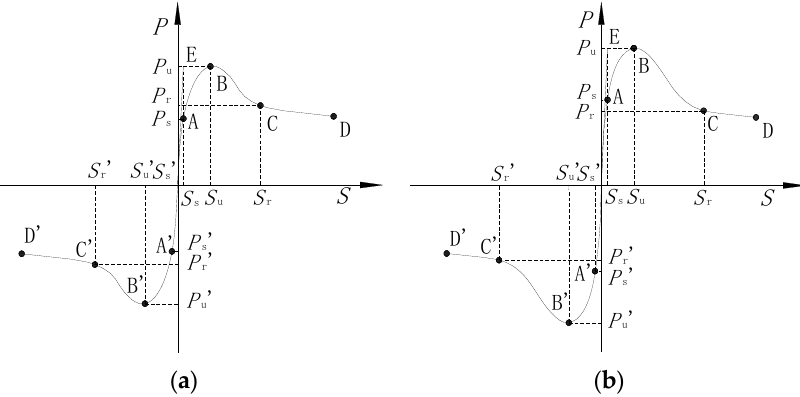
Figure 6. Failure process of bond–slip skeleton curve, they should be listed as: ( a ) P s < P r ; ( b ) P s > P r .